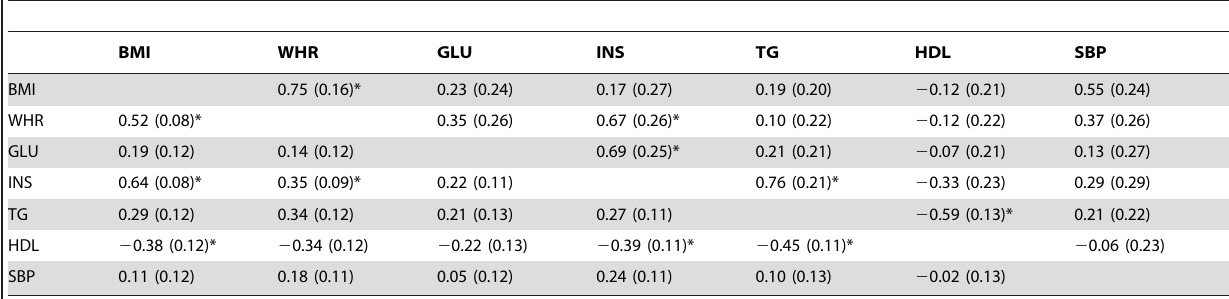
Mean and standard error of the Pearson correlation coefficient for genetic correlations (upper triangle) and residual correlations (lower triangle). An asterisk indicates significance with p , 0.05 adjusted for 21 hypotheses using the two-tailed hypothesis test and normal distribution of the Fisher transformed correlation coefficient.